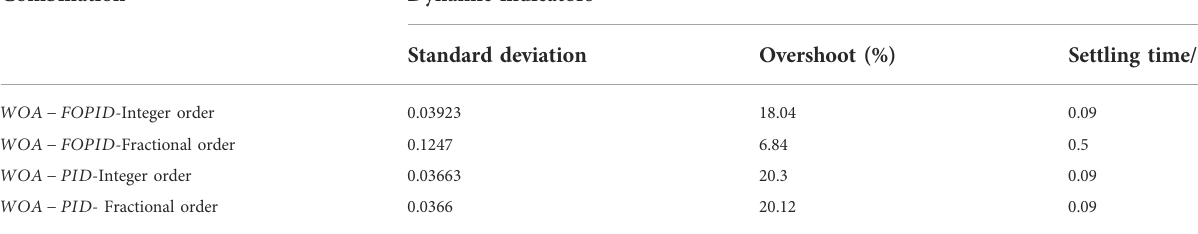
TABLE 7 Comparison of different combination strategies and control